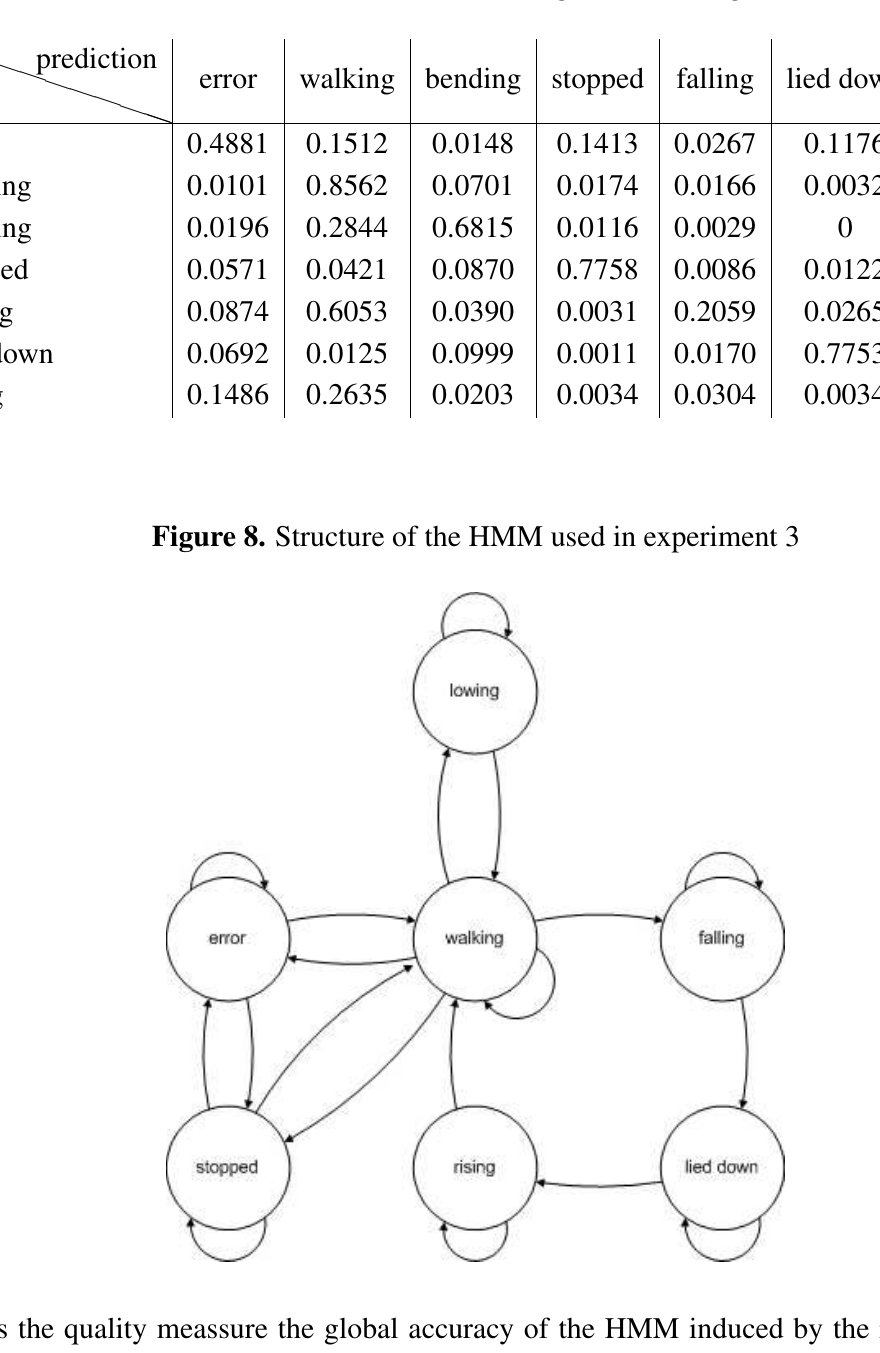
Table 12. Relative Confusion matrix for de HMM generated using a Genetic Algorithm